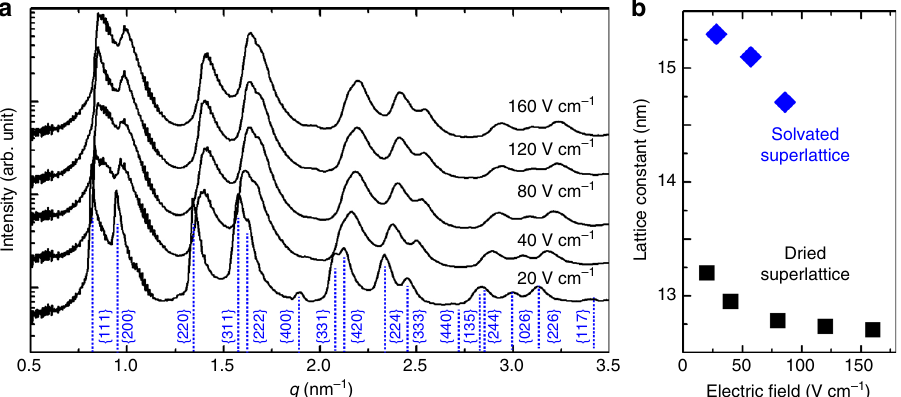
Fig. 6 GISAXS pattern and lattice constant of dried nanocrystal superlattice. a Radial integration of GISAXS patterns of superlattices formed under various electric fi eld strengths. b Lattice constants plotted against applied electric fi eld strength for solvated (blue diamonds) and dried superlattices (black